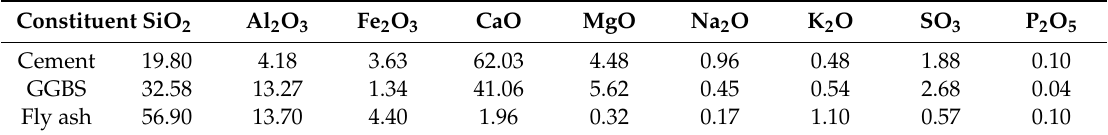
Table 1. Chemical composites of binder materials (wt. %).